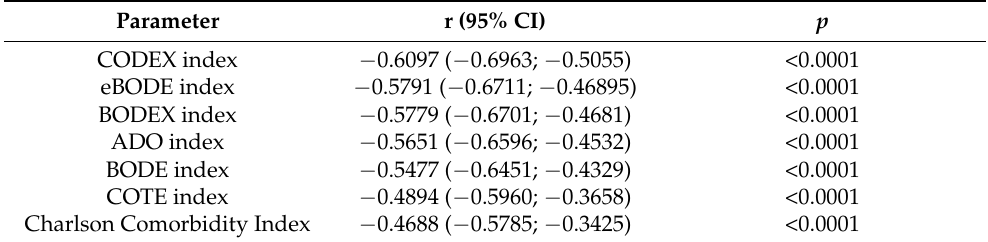
Table 5. Correlation analysis of multidimensional index scores with years lived since baseline.